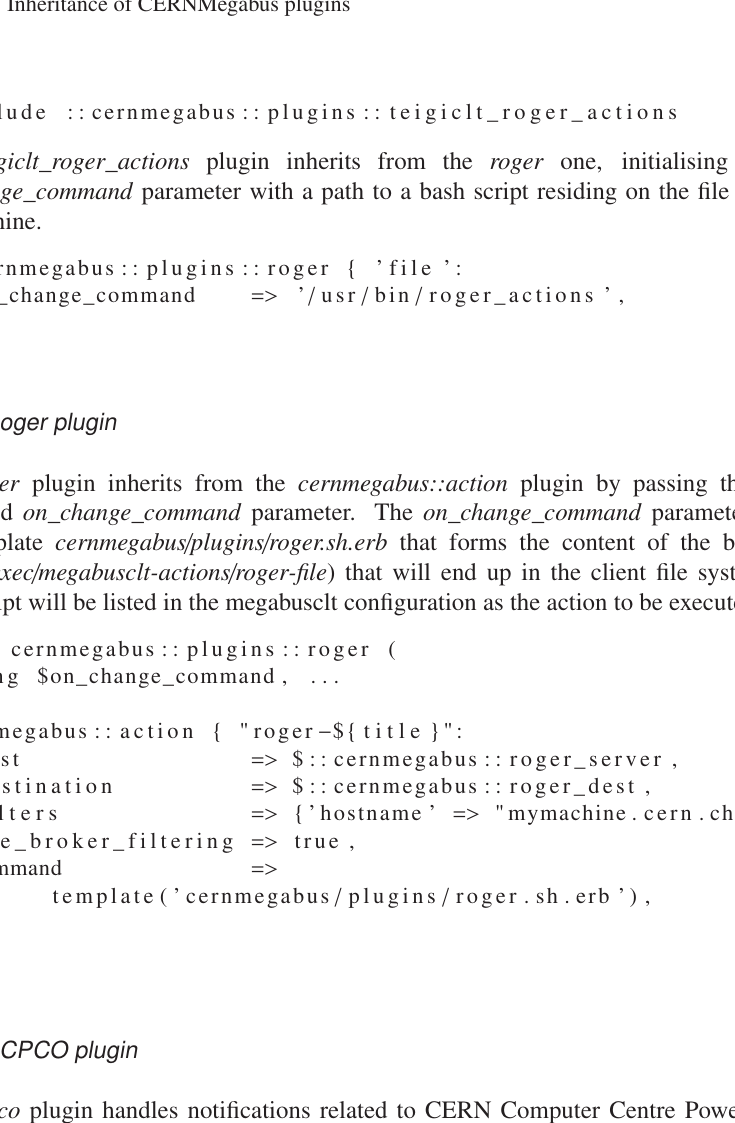
Figure 2. Inheritance of CERNMegabus